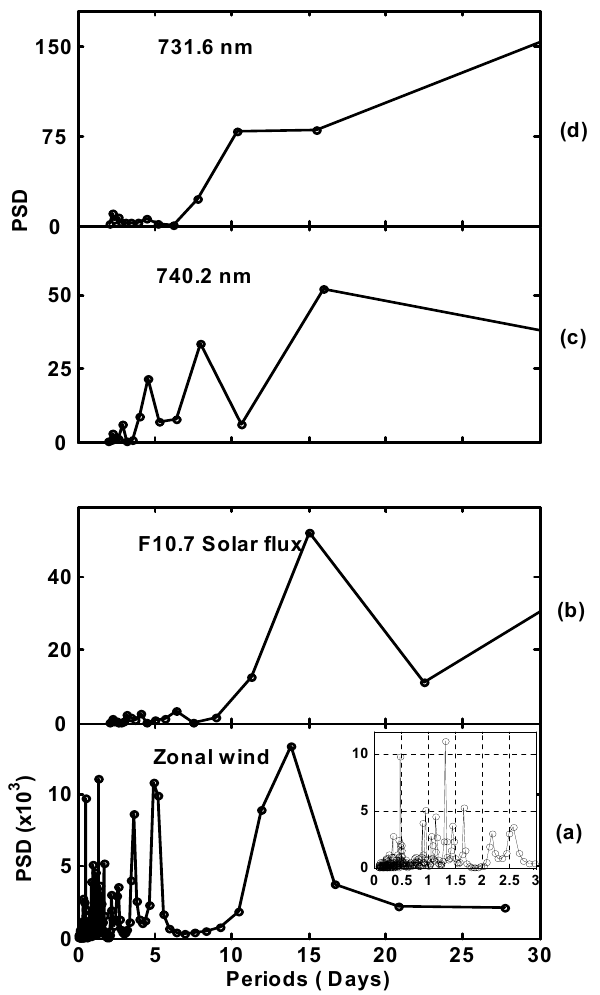
Fig. 2. Top two panels ( c ) and ( d ) show the power spectral density distribution of dominant periodicities in the dayglow emission in- tensity at 740.2nm and 731.6nm, respectively. Panels ( a ) and ( b ) exhibit the same for F10.7cm solar flux and zonal wind. Inset fig- ure in panel (a) exhibits the power spectral density distribution of periodicities below 3 days in the zonal wind, to highlight that the semidiurnal mode is more dominant than the diurnal